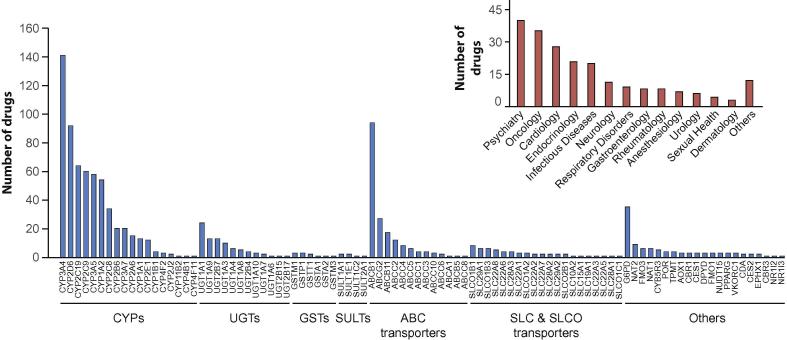
Overview of the genes and drug considered for analysis. Large column plot depicts the number of drug associations per gene. In total n = 212 genes were considered. The inlet shows the distribution of drugs across therapeutic areas.